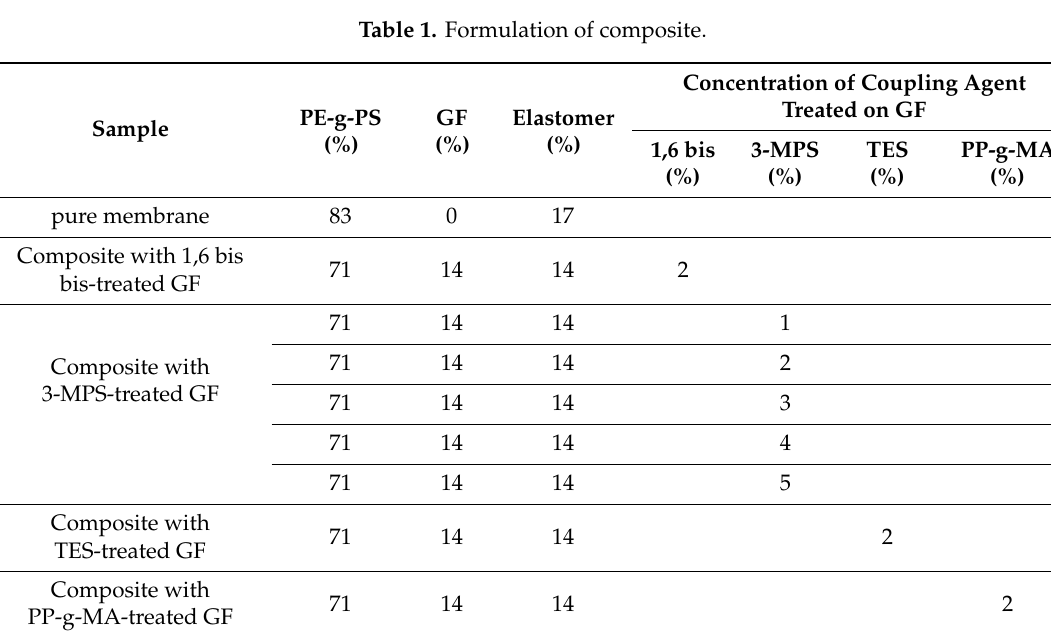
Table 1. Formulation of composite.